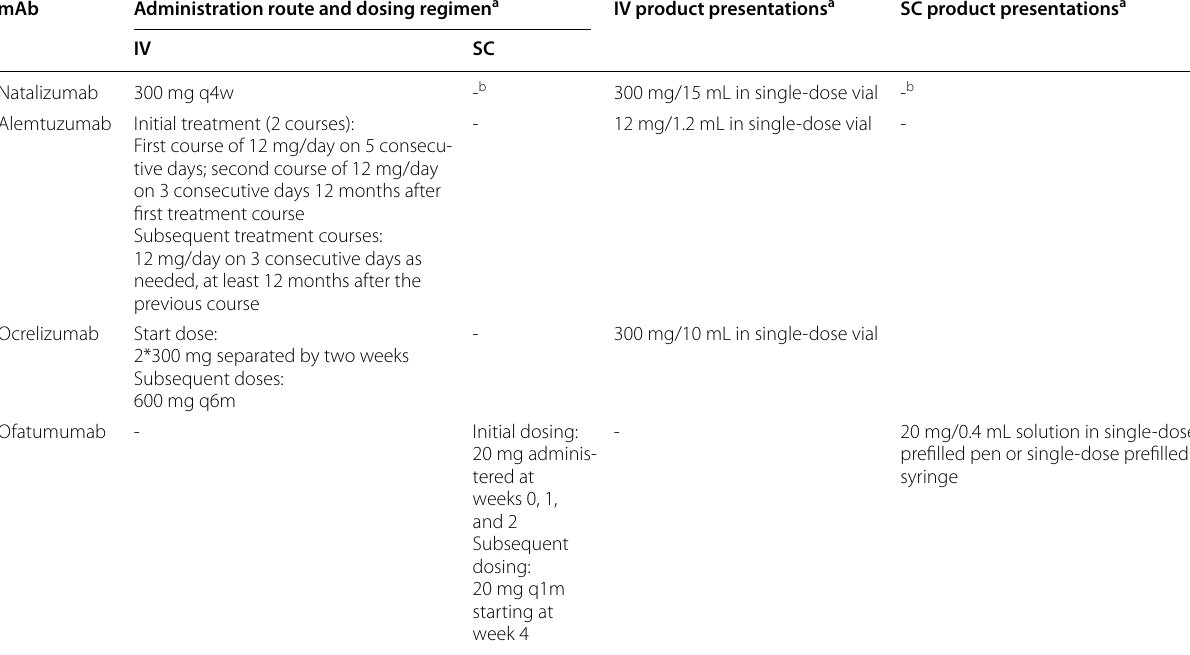
Table 3 mAbs authorized for the treatment of MS in the US (up until September 2022): administration routes, dosing regimens and product presentations (adult